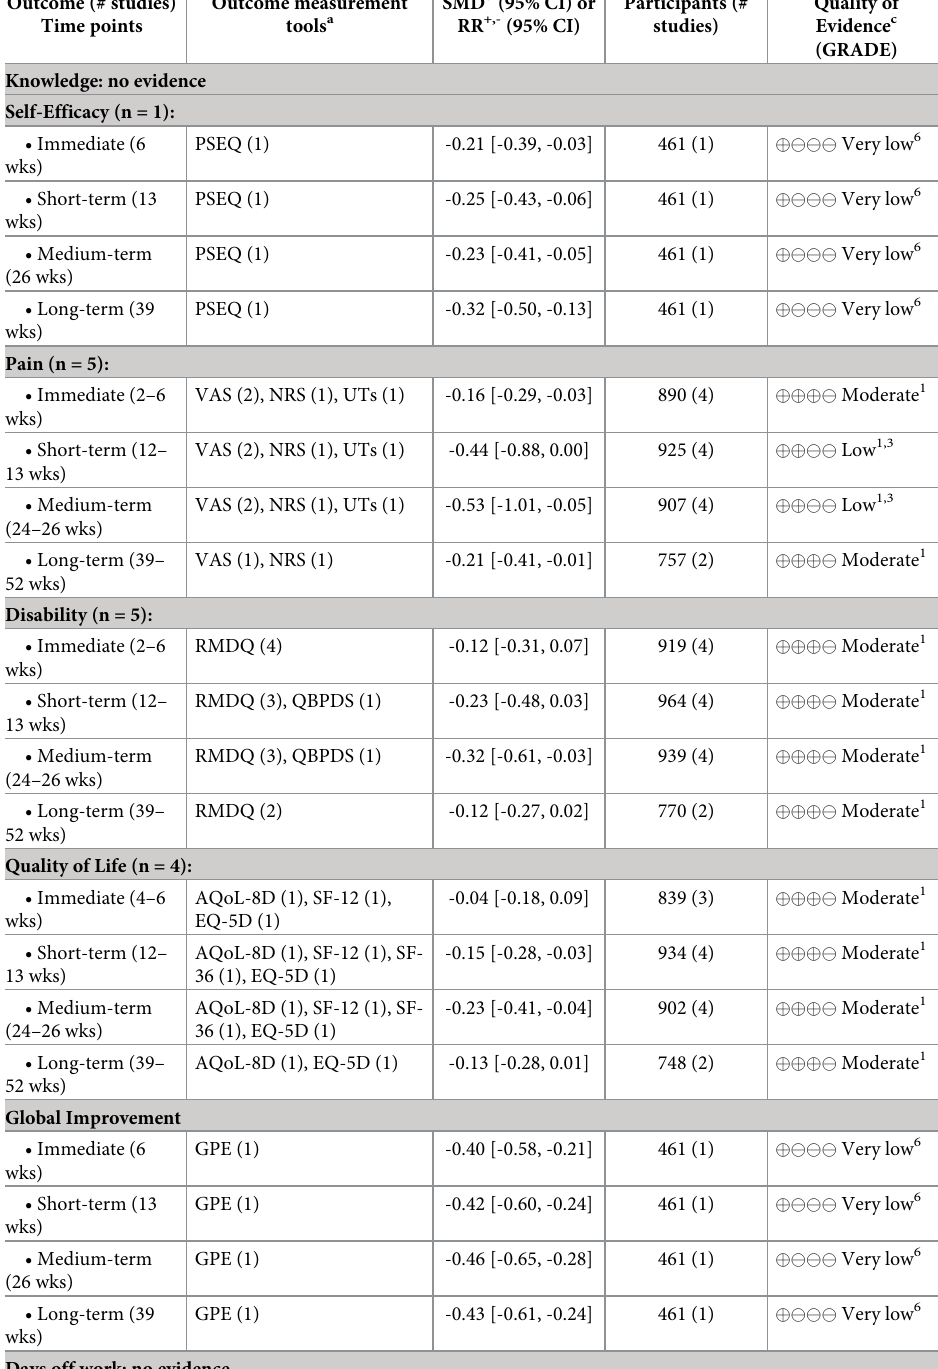
Table 6. Summary of findings: Education materials compared with no intervention (usual care) for chronic low back